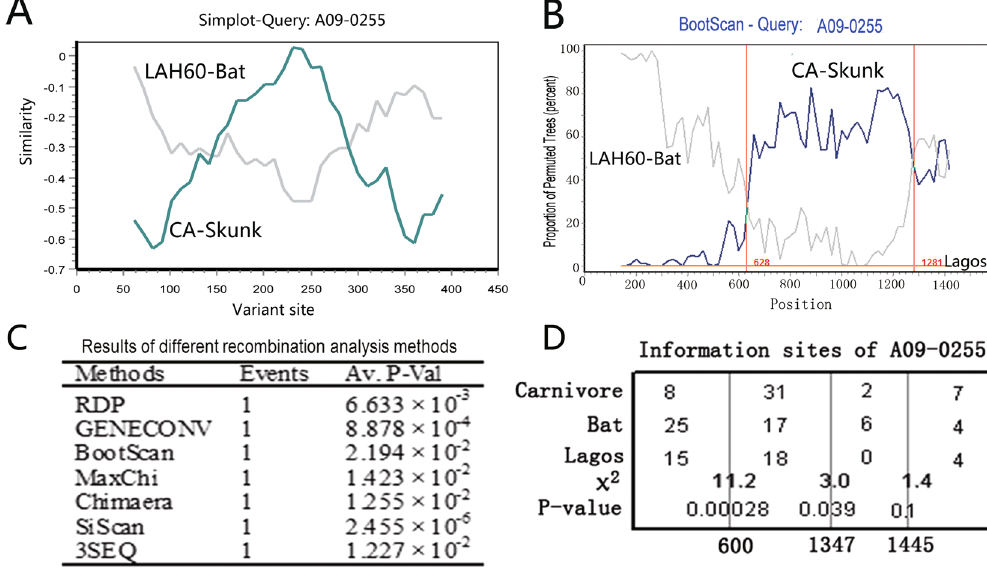
Figure 1. Recombination analysis of SCSKV and bat and skunk RABVs. ( A ) Variable site comparison of the G genes of SCSKV and carnivore and bat RABV representatives, A09-0255, CA, and LAH60. SCSKV A09- 0255 was used as a query. The y-axis gives the percent identity between A09-0255 and two representatives of the parental lineages. ( B ) A bootscan plot of A09-0255 with a sliding window of 350 bp and a width of 20 bp using the complete G gene. The y-axis represents the percentage of permuted trees. Two Lagos bat viruses, 8619NGA and 0406SEN, were used as an outgroup. Analyses were performed using Simplot software. Vertical lines represent crossover sites. ( C ) Statistical analysis of the recombination event in the A09-0255 G gene using RDP 3.0. P-values of seven statistical methods implemented in RDP 3.0 to identify recombination are listed. ( D ) Analysis of informative sites for identification of potential recombination breakpoints. Three sites with maximum χ 2 values are indicated by three vertical lines. The χ 2 value and P-value of Fisher’s exact test are shown near the vertical lines. The Lagos virus isolate 8619NGA is used as the